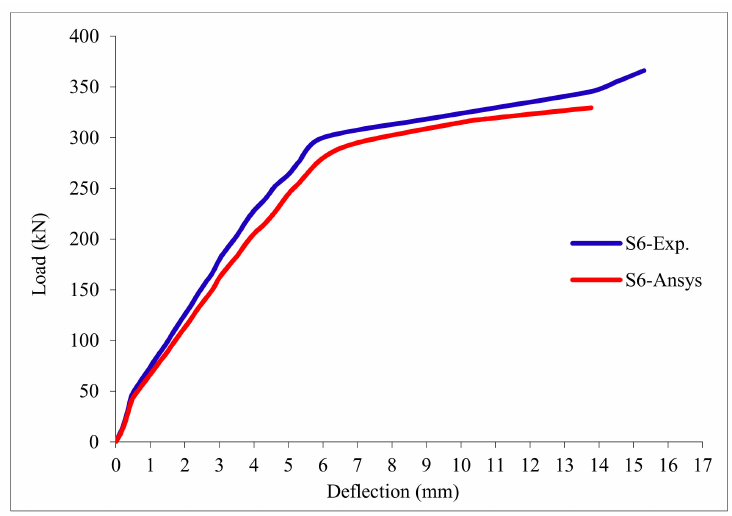
Figure 30. Load deflection curve for control slab S5.